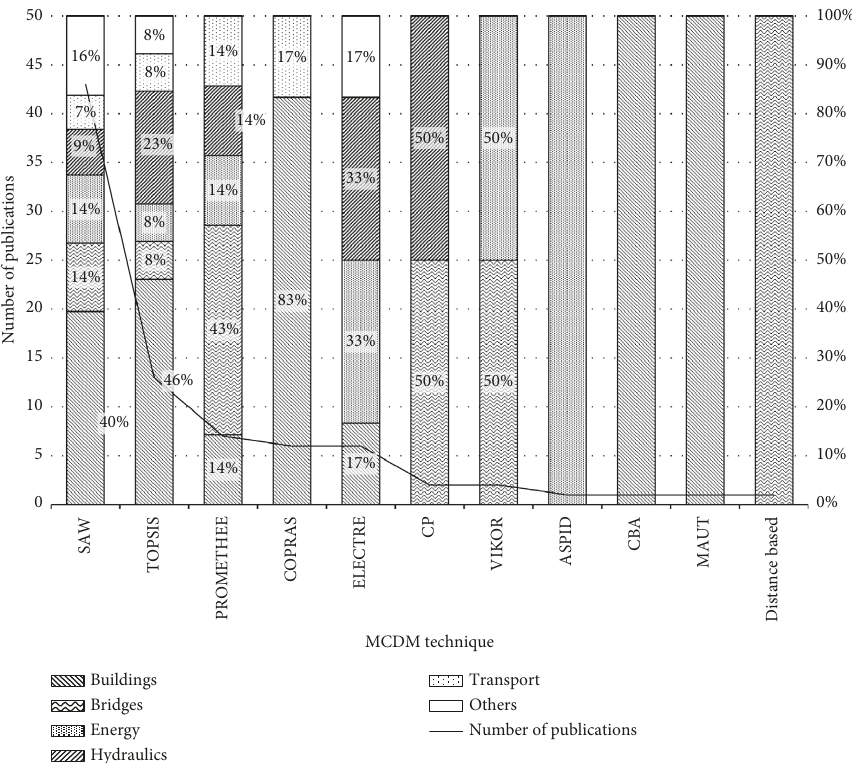
Figure 4: MCDM assessment techniques applied within the reviewed